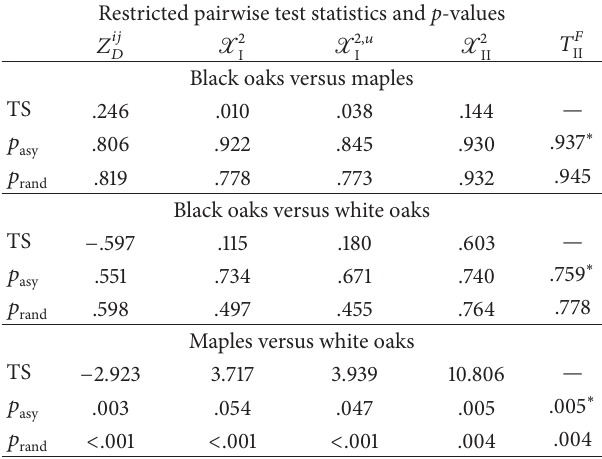
Table 19: The test statistics and the p -values for the unrestricted pairwise symmetry analysis for the Lansing Woods data. Row labelings and the asterisks are in Table